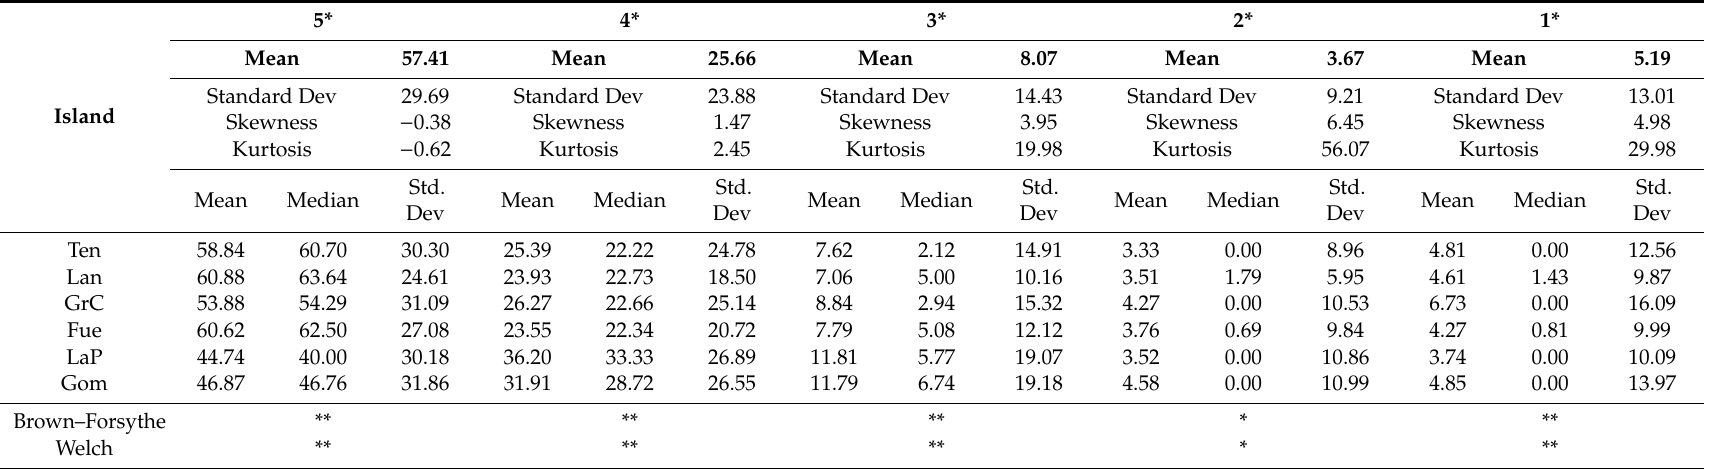
Table A1. Percentage of reviews out of total restaurant reviews per score (5*–1*) and island (Brown–Forsythe and Welch tests).